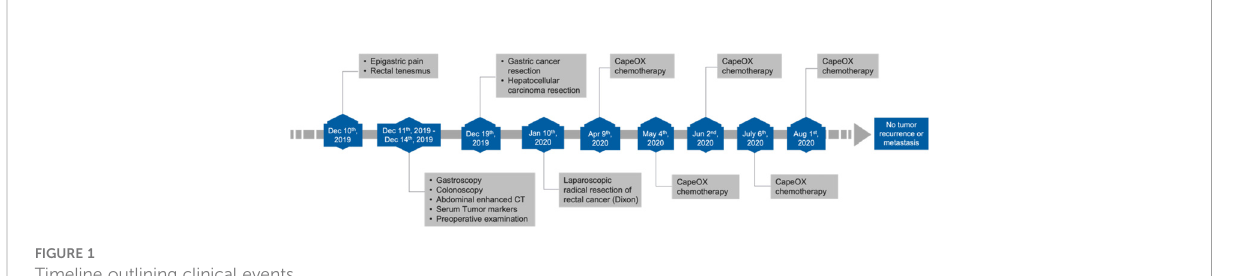
FIGURE 1 Timeline outlining clinical